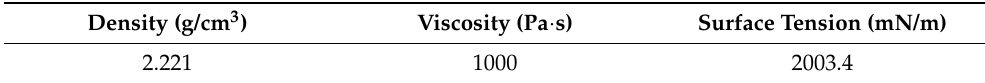
Table 1: density, 2.221g/cm 3 ; viscosity, 1000 Pa · s; and surface tension, 2003.4 mN/m. Table 1. Material properties of nano glass powder at 950 ◦ C.